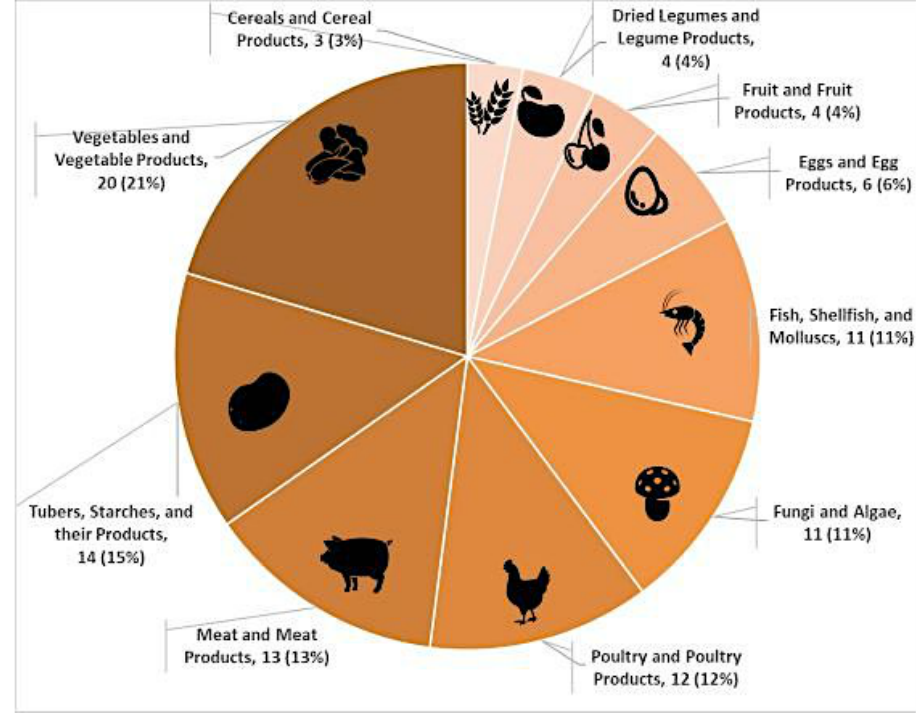
Figure 3. Example of system output: distribution of consumed